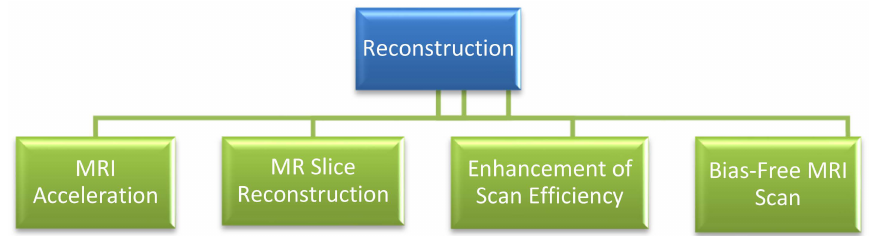
Figure 7. Grouping of reconstruction